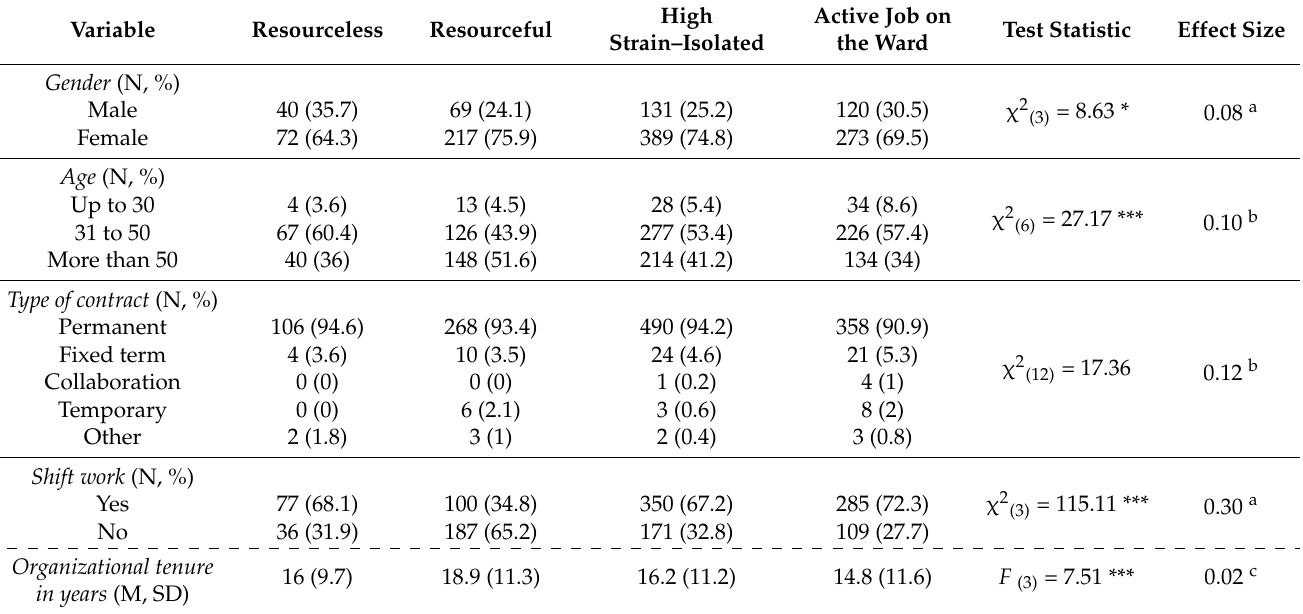
Table 4. Socio-demographic and occupational characteristics for the four latent